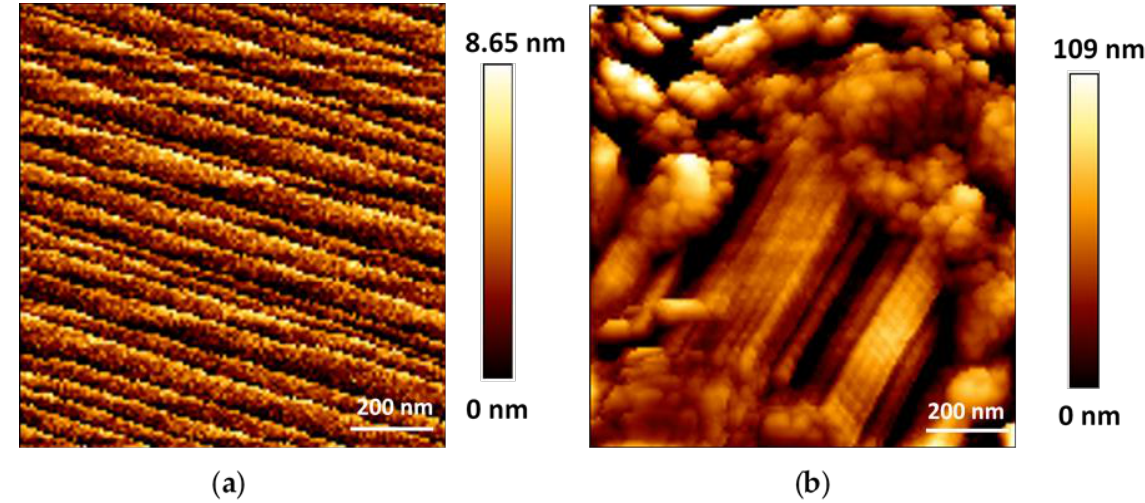
Figure 3. Topography of ( a ) microMOF (+) crystal and ( b ) a microMOF ( − ) crystal in water (128 pixels × 128 pixels). AFM mapping presents ordered crystalline planes typically observed for microMOFs (+) and some defects in the case of microMOFs (−).